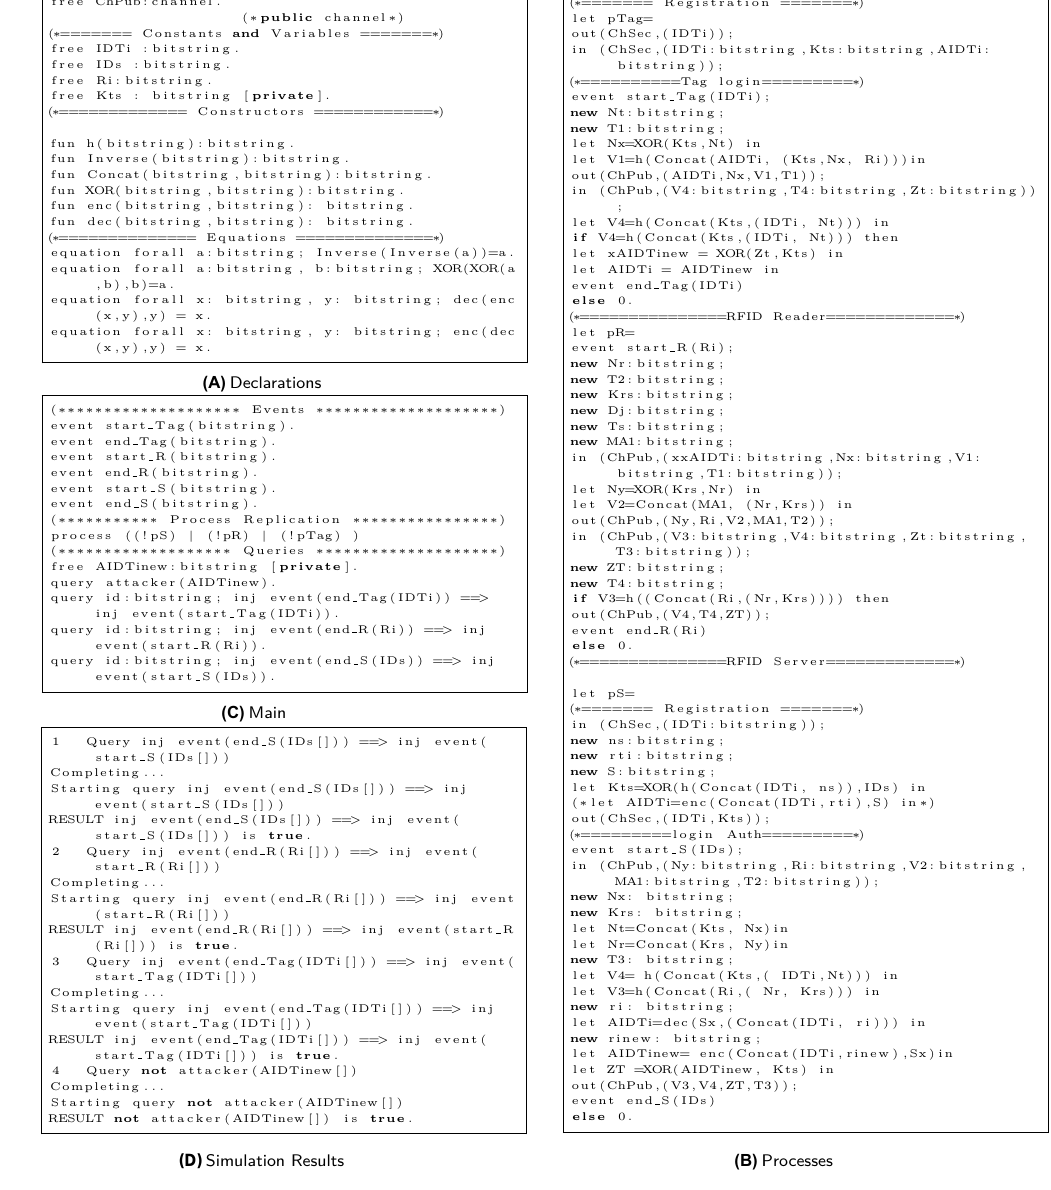
Figure 6. ProVerif